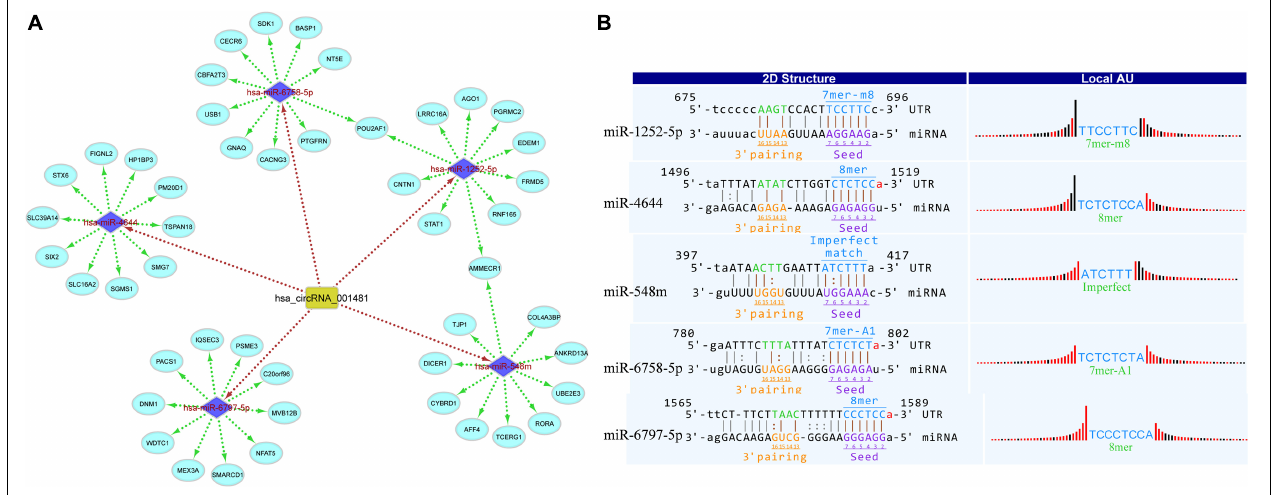
FIGURE 4 | (A) CircRNA_001481_miRNA_mRNA interaction network comprising 5 miRNAs and 50 targets. The top 10 mRNA targets of each miRNA are shown in this network constructed by Cytoscape 3.6. (B) Top MREs of miRNAs and 2D structure showing the MRE sequence analysis for hsa_circRNA_001481.